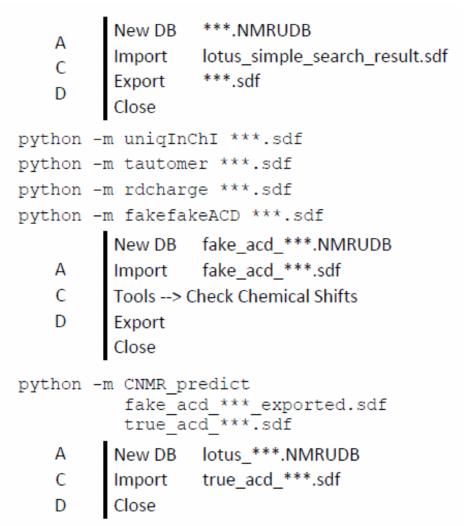
Figure 1. Imaged view of the content of the template file that leads from a LOTUS search result file to an ACD/Labs database file with predicted 13 C NMR chemical shift values. The *** are intended to be replaced by a name, like “turnip” in the present